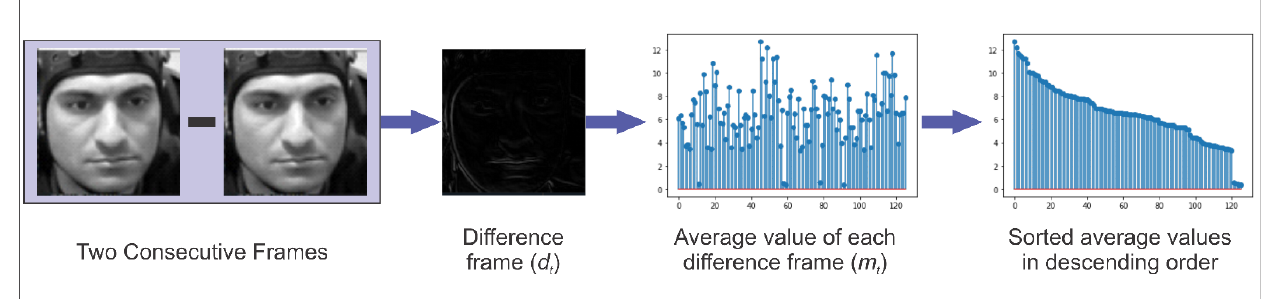
Figure 1. The process of finding frames containing meaningful information (the facial image adopted from [63]).